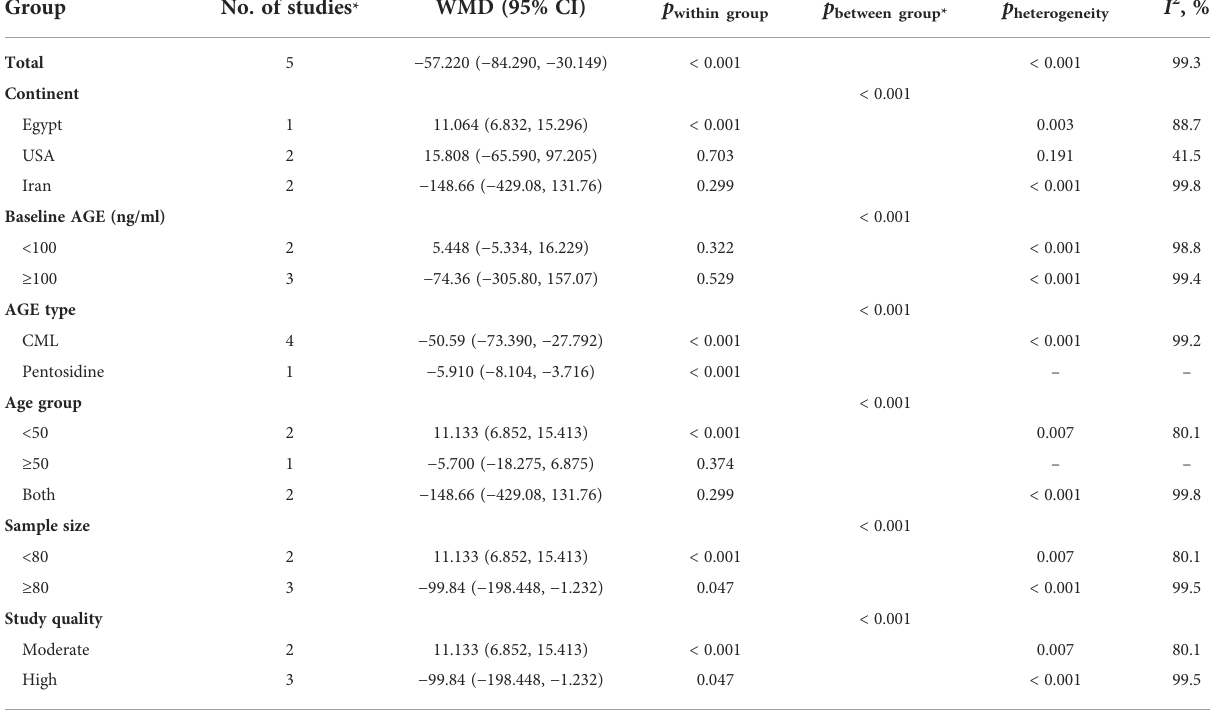
TABLE 5 Subgroup analysis for the comparison of mean circulating AGE between obese and non-obese participants. Group